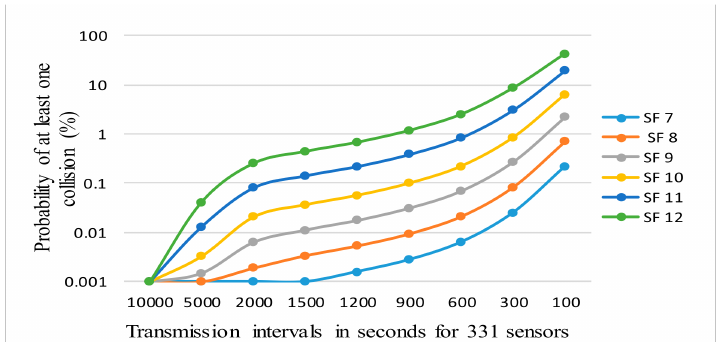
Figure 4. E ff ect of the spreading factor (SF) and report period on the probability of collisions for 331 sensor nodes (24-byte payload, C = 3 channels, one packet per interval T, calculated using Equation